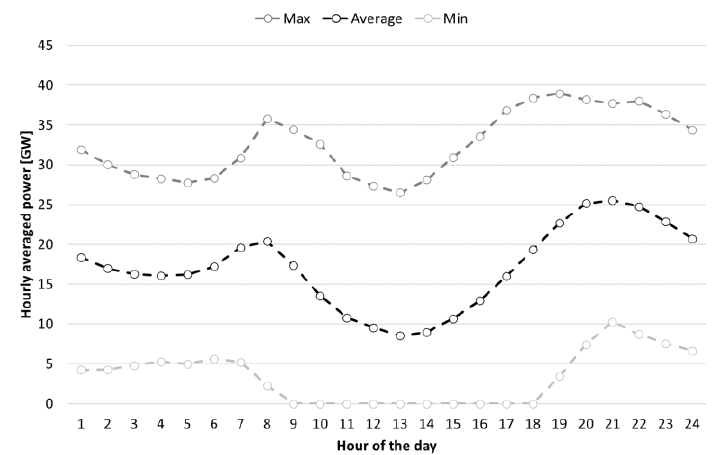
Figure 11. Hourly averaged power of non-renewable sources during the day in Case 1; average, maximum and minimum values.